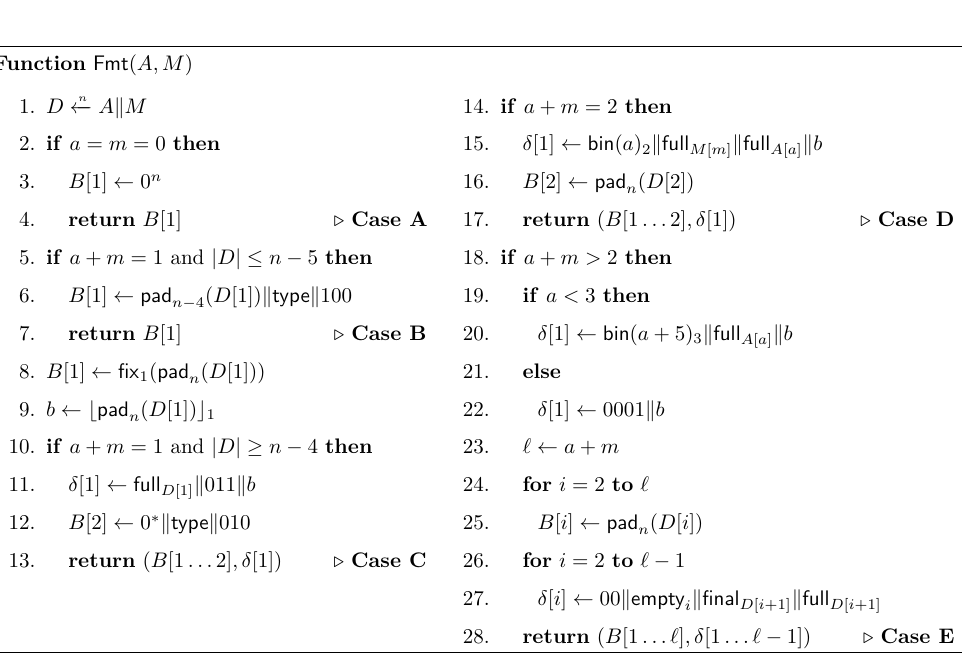
Figure 7: The formatting function Fmt of